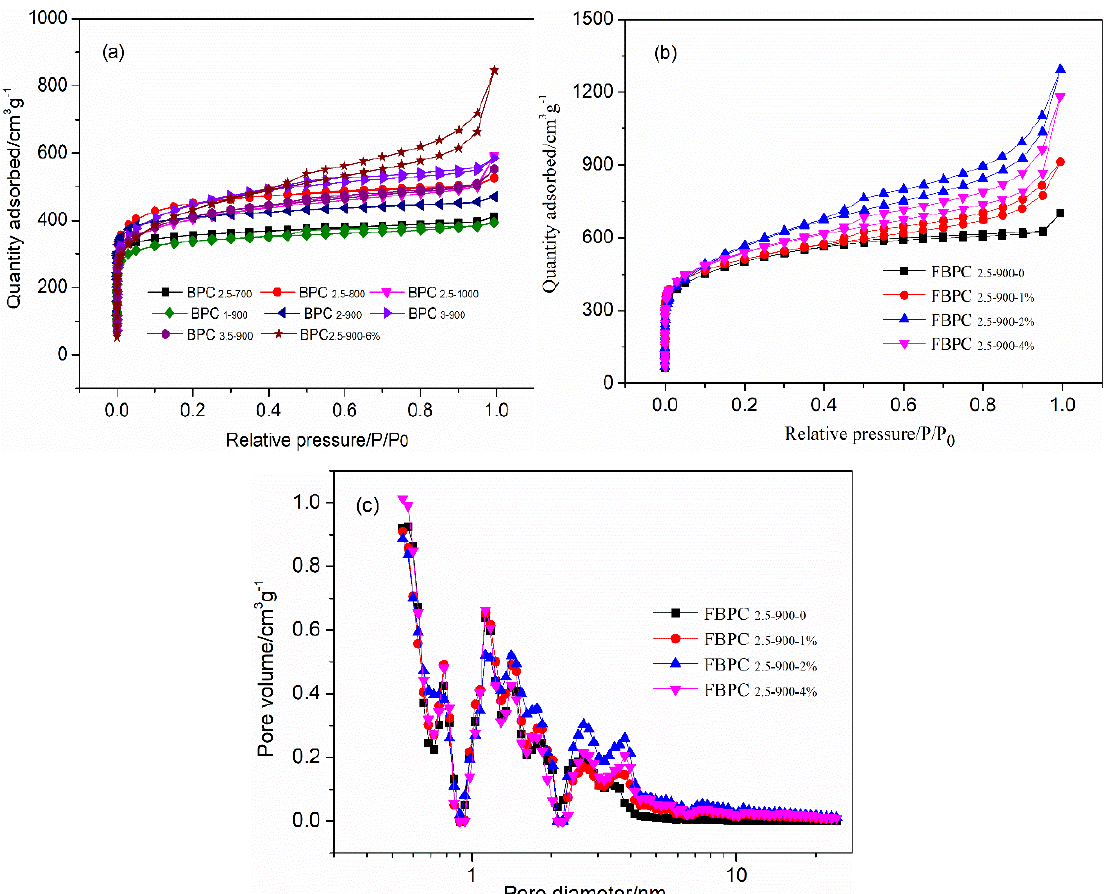
Figure 1. ( a ) Nitrogen adsorption/desorption isotherms of the BPC and FBPC samples; ( b ) nitrogen adsorption/desorption isotherms; and ( c ) DFT pore size distribution of the FBPC samples.